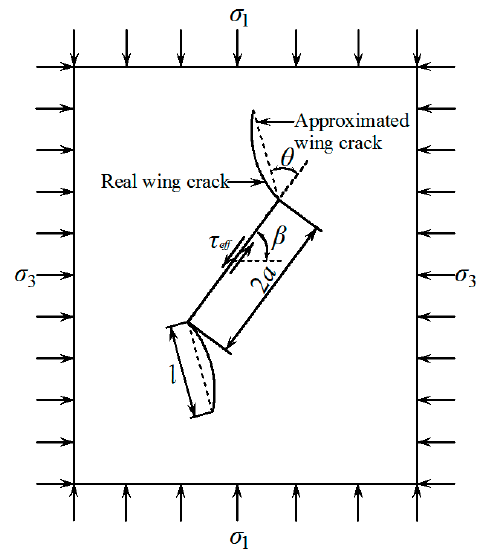
Figure 1. Wing crack model.